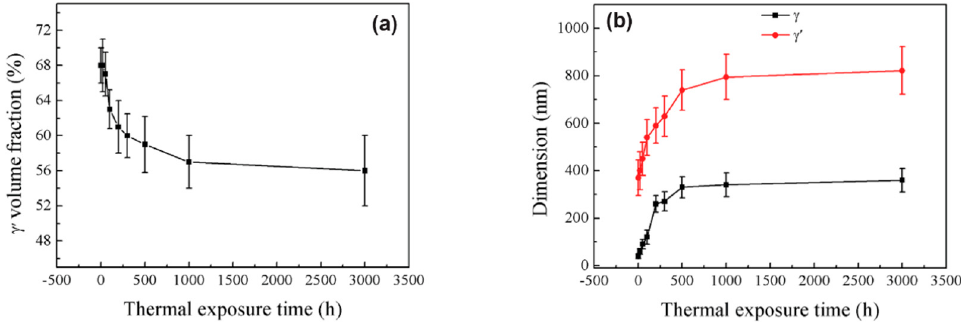
Figure 3. The quantitative microstructural parameters of DD11 alloy after thermal exposure at 1070 °C for different durations. ( a ) γ ’ volume fraction; ( b ) γ ’ size and γ channel width [27].